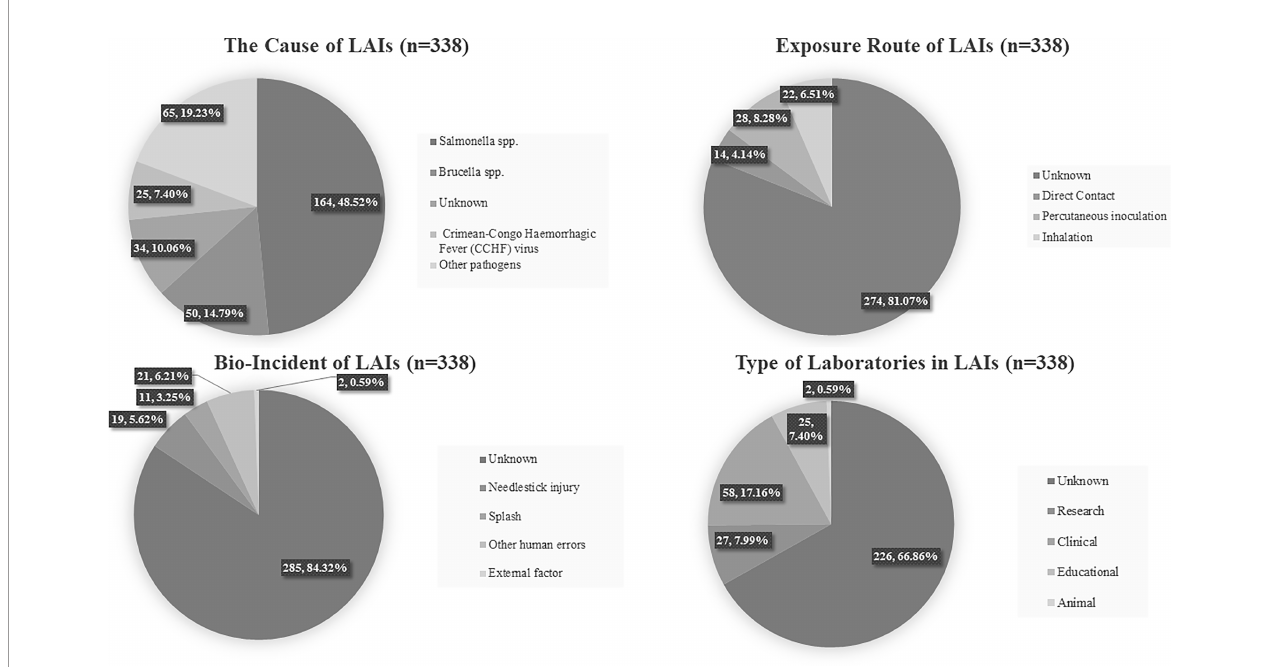
FIGURE 2 | Simpli fi ed pie chart showing the results of our analysis of 338 LAIs from previous reports. The causative agent, exposure route, bio-incident, and type of laboratory are given.